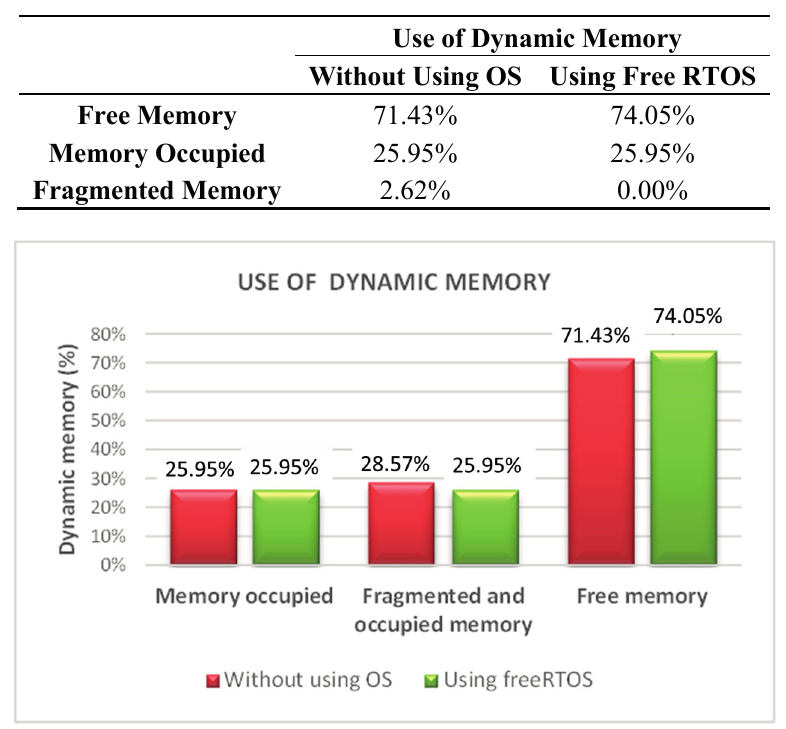
Table 4. Use of dynamic memory.